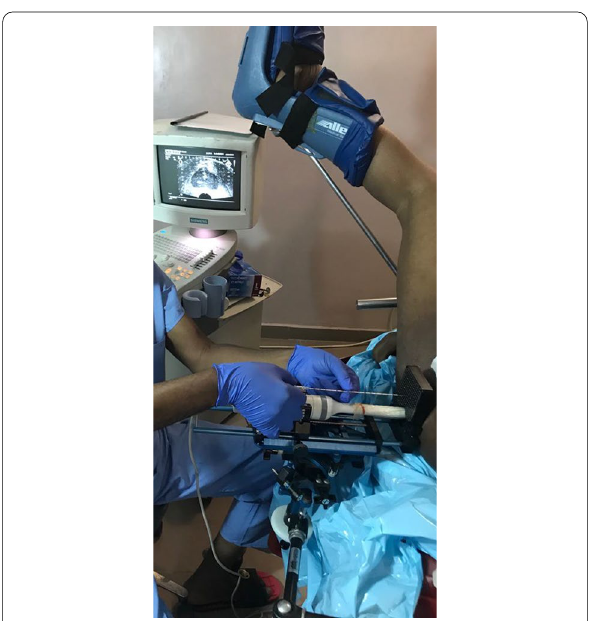
Fig. 3 Consultant Radiation Oncologist performing the radioactive Iodine 125 seeds implants